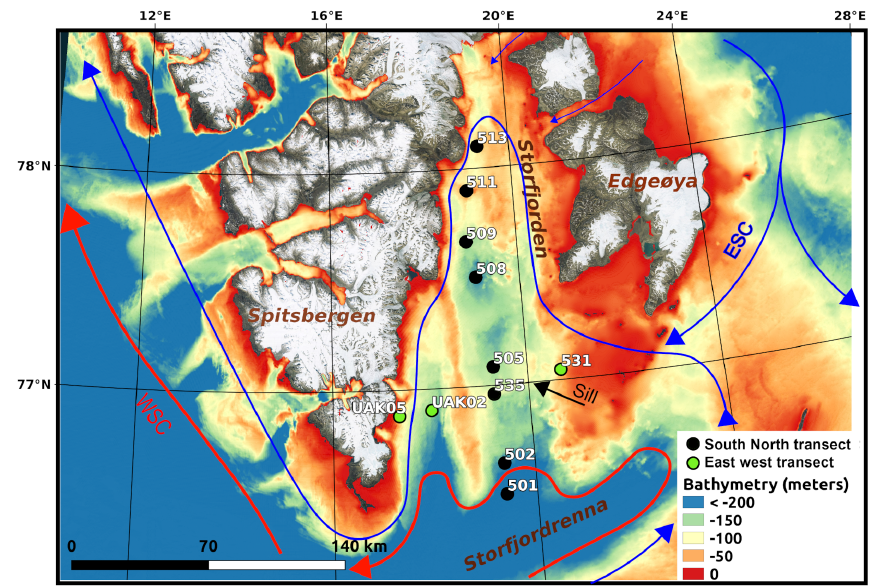
Figure 1. Stations visited for optical measurements during the UAK2020 cruise in Storfjorden (Svalbard) along with bathymetry shown between 0–200m (red to blue colours). This included seven stations along a south–north transect (marked black), from deep ( > 250m) waters at the entrance of the fjord to a shallow ( < 50m) area in the inner fjord. Four stations across the fjord entrance (along an east–west transect, marked green) were located at the latitude of the sill. Bathymetry is from GEBCO. The directions of the two main surface currents are given as arrows. The Svalbard land part comes from Bing aerial images (© Microsoft). The map projection is